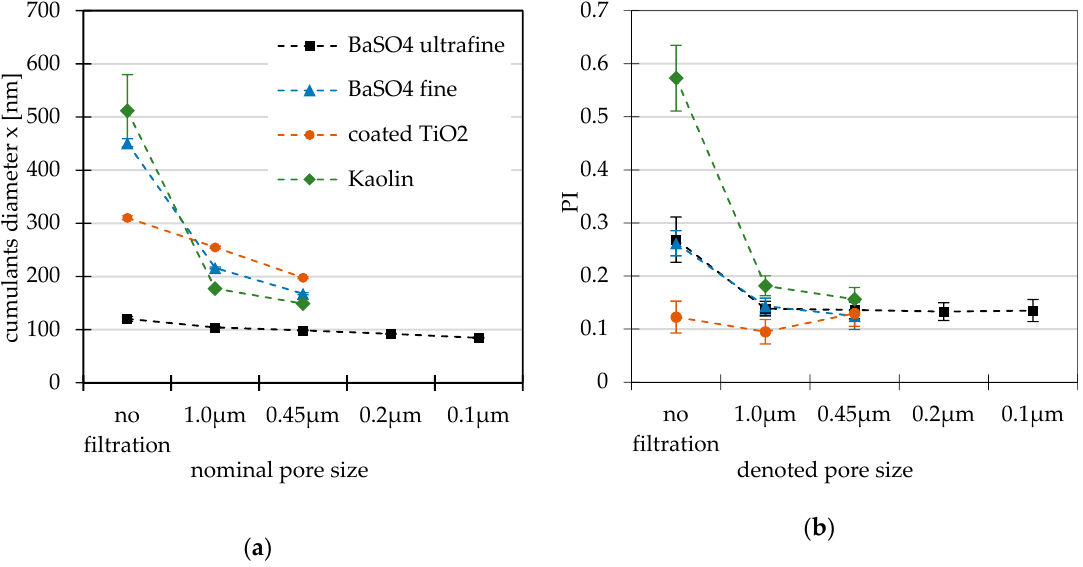
Figure 3. Averaged results of DLS measurements of RTMs of feedstock suspension and after filtration with PTFE membranes: ( a ) Mean cumulants diameter; ( b ) mean polydipersity index (PI).